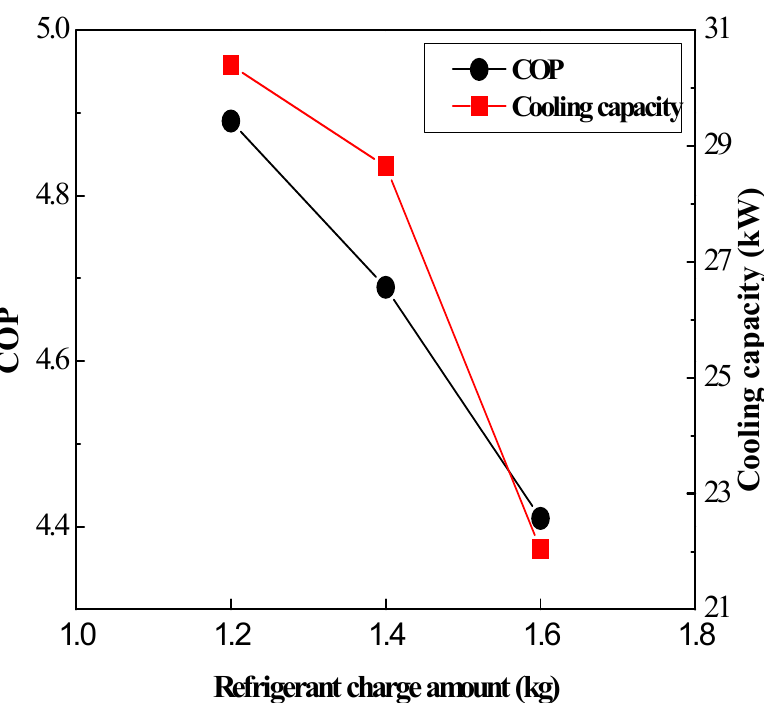
Figure 5. Cooling capacity and COP of the two parallel refrigeration cycles with the refrigerant charge amount for a special purpose vehicle.